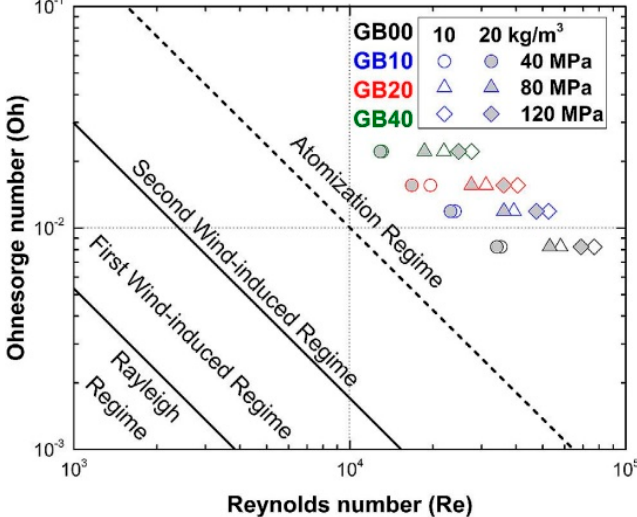
Figure 7. Ohnesorge diagram for all fuels under 10 kg/m 3 and 20 kg/m 3 ambient gas densities under 40, 80 and 120 MPa rail pressures [Reprinted from Fuel Processing Technology, Vol. 178, Shubhra of biodiesel-blended gasoline fuel in a constant volume chamber, Copyright (2018); with permission from